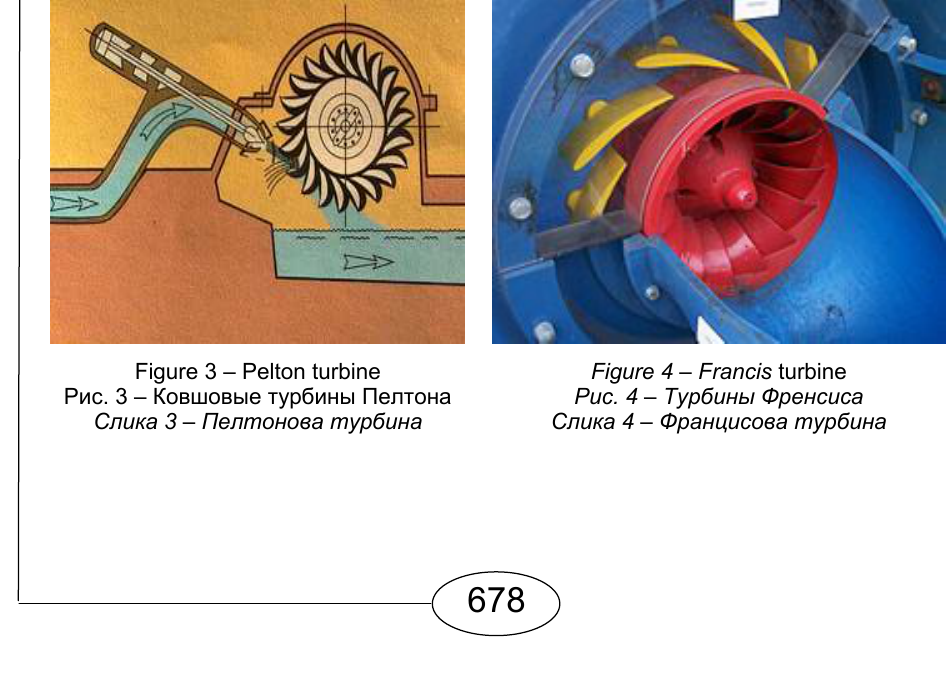
Figure 4 – Francis turbine Рис . 4 – Турбины Френсиса Слика 4 – Францисова